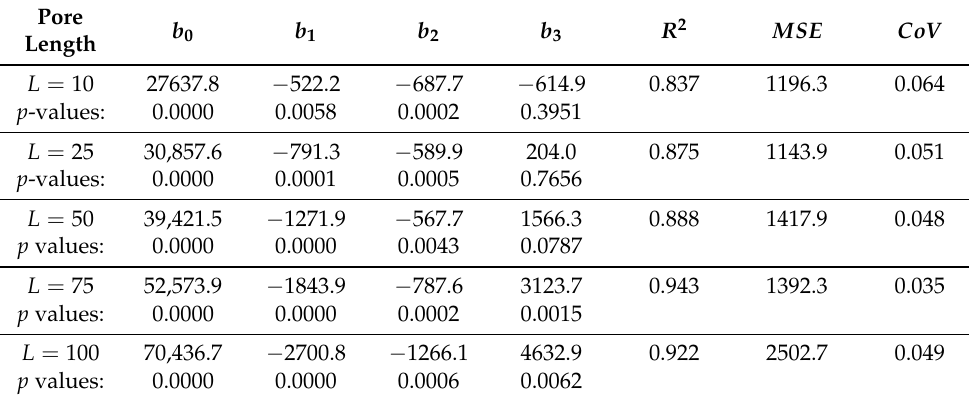
Table 1. Estimated regression models (6) for selected pore lengths L